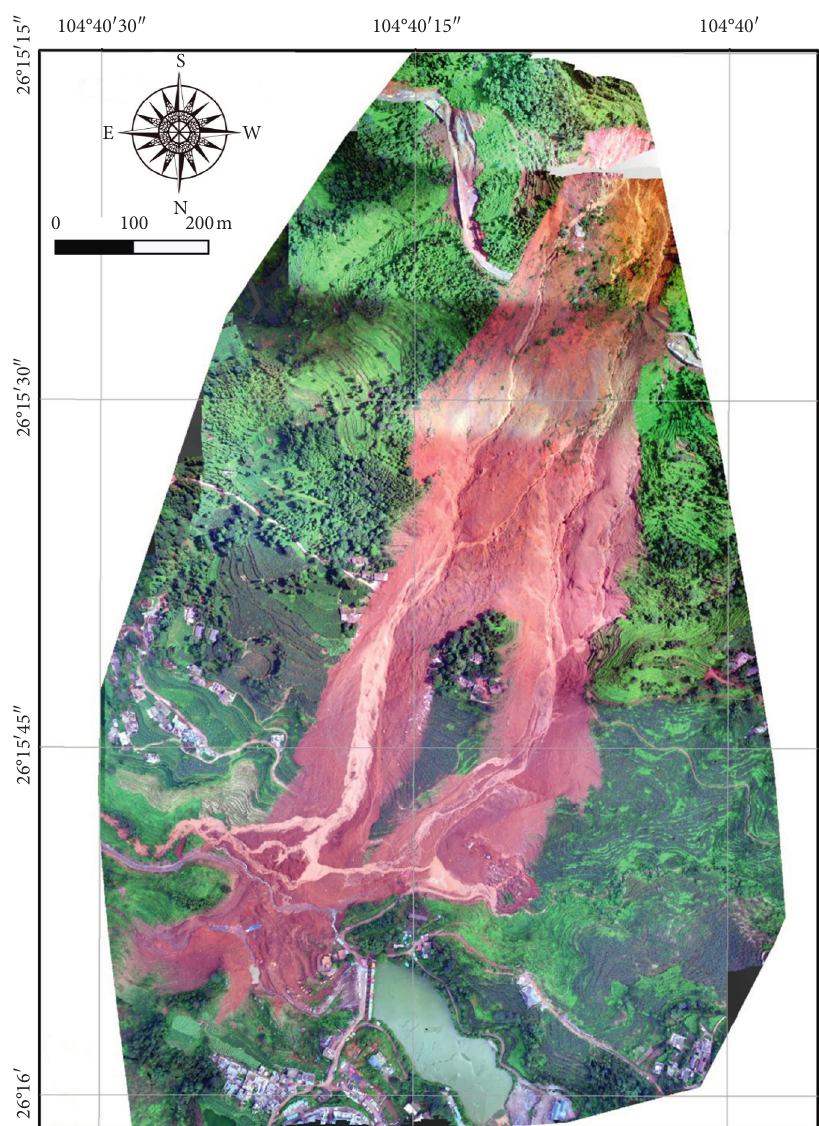
Figure 2: UAV photograph of the Shuicheng